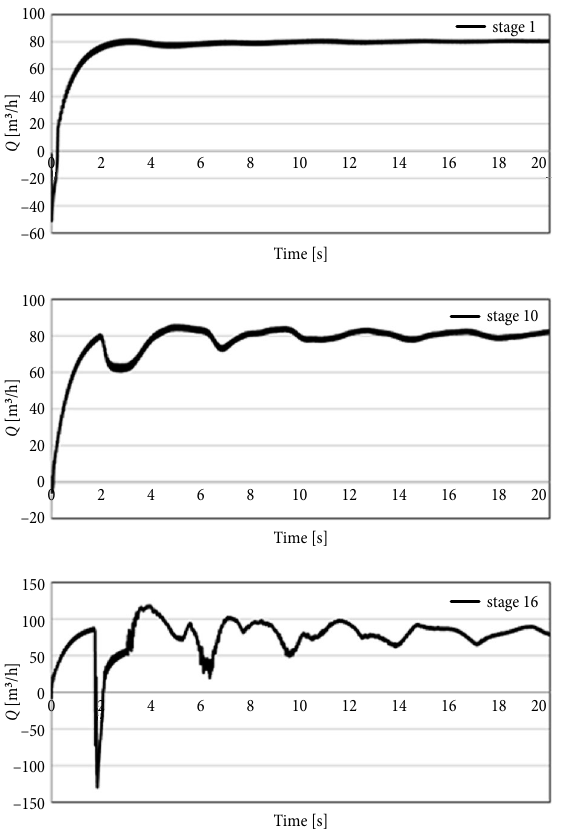
Fig. 8. Dependencies of flow variations in the vertical pipe at different depths over